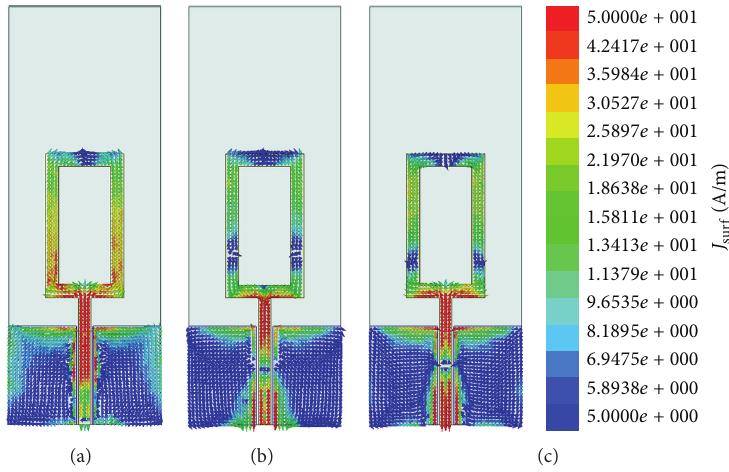
Figure 3: Simulated current density distribution in the proposed antenna at (a) 2.4 GHz, (b) 5.2 GHz, and (c) 5.8 GHz.